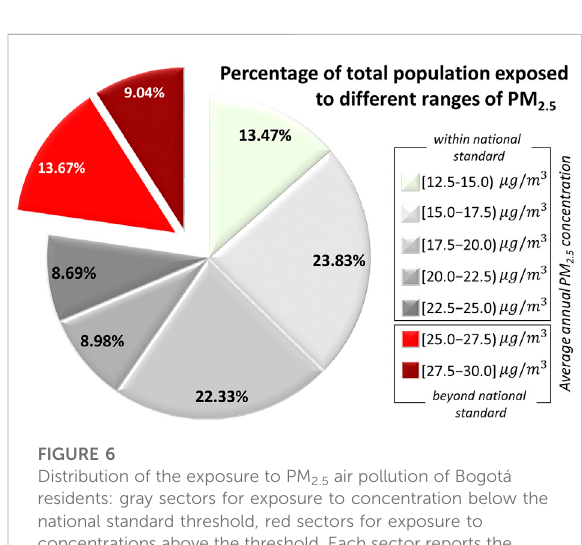
FIGURE 6 Distribution of the exposure to PM 2.5 air pollution of Bogotá residents: gray sectors for exposure to concentration below the national standard threshold, red sectors for exposure to concentrations above the threshold. Each sector reports the percentage of city residents exposed at a speci fi c pollutant